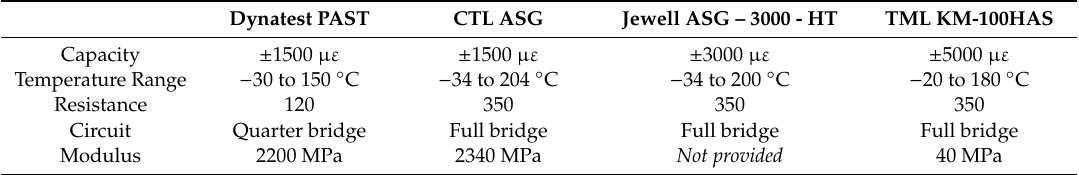
Table 1. Specifications of some asphalt strain gauges (ASGs) available on the market.